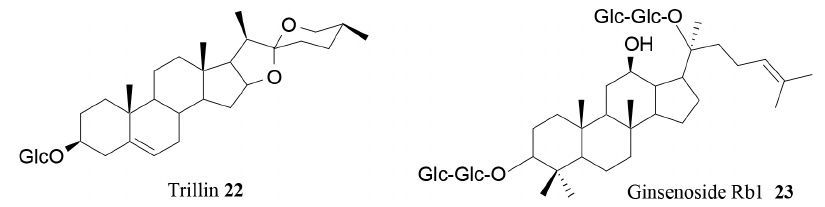
Figure 7. Further saponins with anti-obesity properties [65,95].